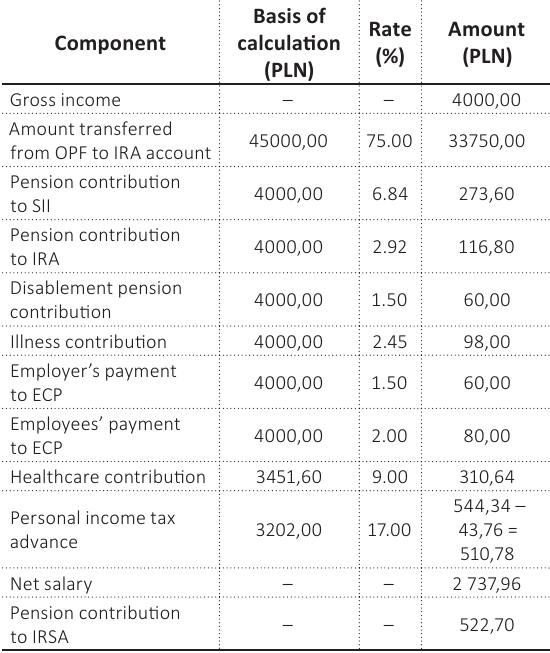
Table 8. Variant 2 – pension amounts after